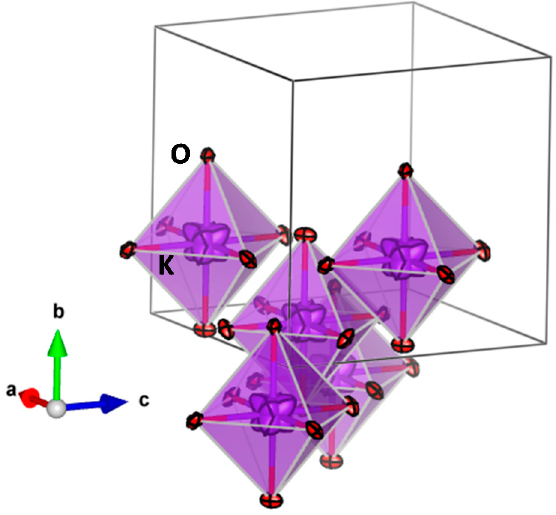
Figure 4. Close up of the coordination polyhedra around K + ions enhancing the lobes of the anisotropic thermal ellipsoids, with K + statistically occupying one in four lobes within each polyhedron. (Sb,Te)O 6 octahedra are not represented for clarity.